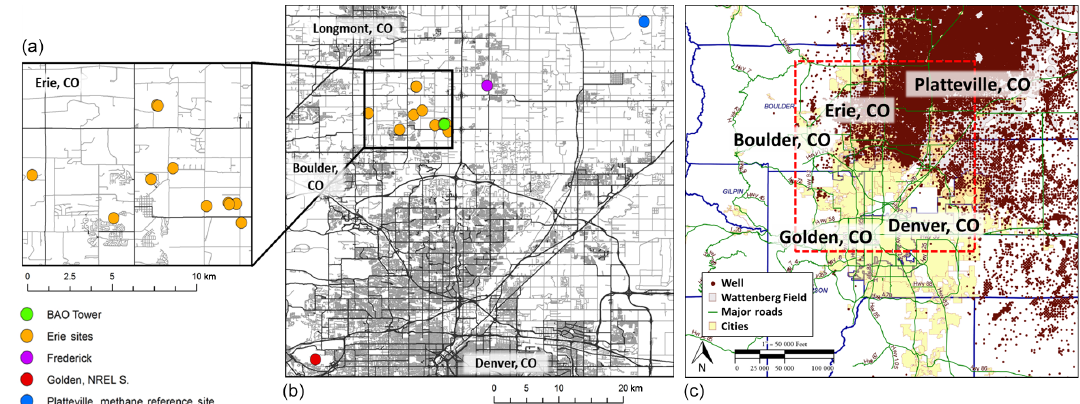
Figure 2. Maps of Colorado deployment area with every site displayed in panel (b) and the Erie sites displayed in panel (a) . Panel (c) indicates active and inactive wells in the Wattenberg Gas Field along with major urban areas and counties; data are courtesy of the Colorado Oil and Gas Conservation Commissions (COGCC, 2017).